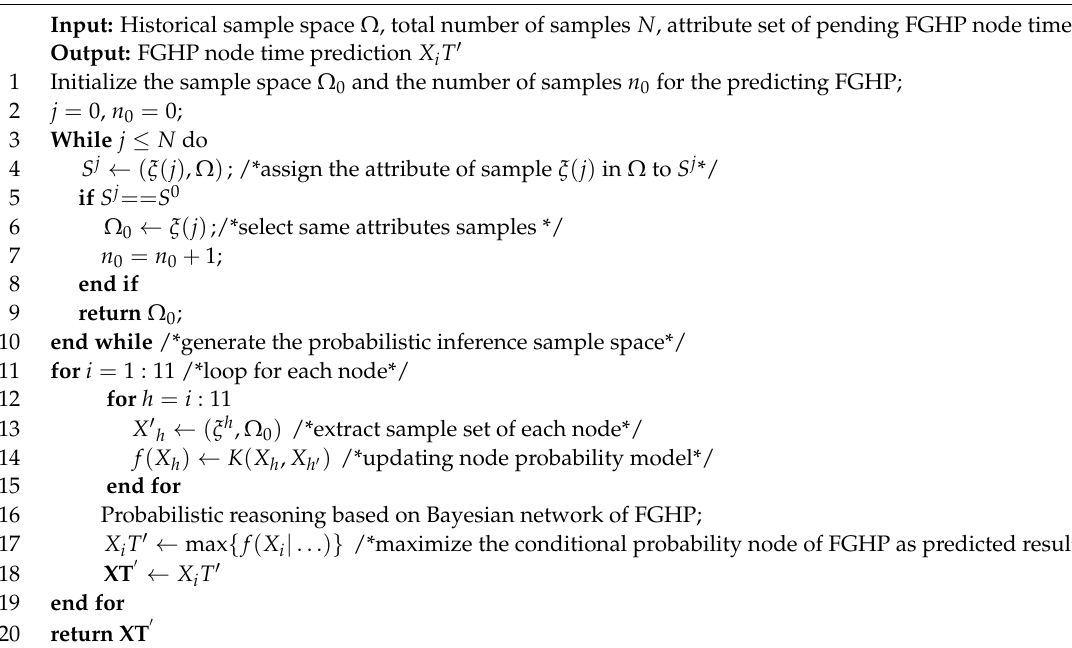
Algorithm 1: Time prediction of FGHP